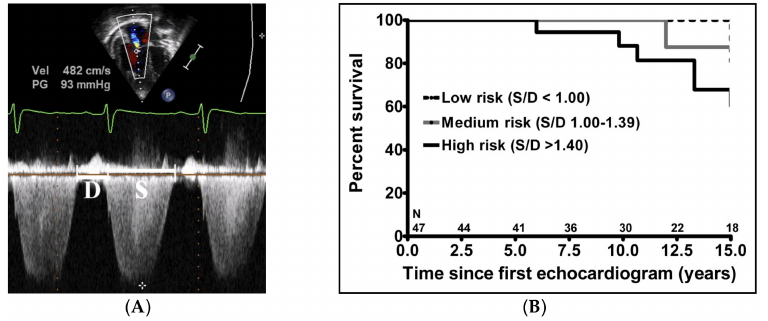
Figure 7. The systolic (S) to diastolic (D) time ratio from tricuspid regurgitation velocity can be measured as an indicator of right ventricular function. ( A ) Measurement of the S/D ratio from a continuous wave Doppler spectrogram; ( B ) An increase in the S/D ratio predicts worse outcome in children with PAH. [68].